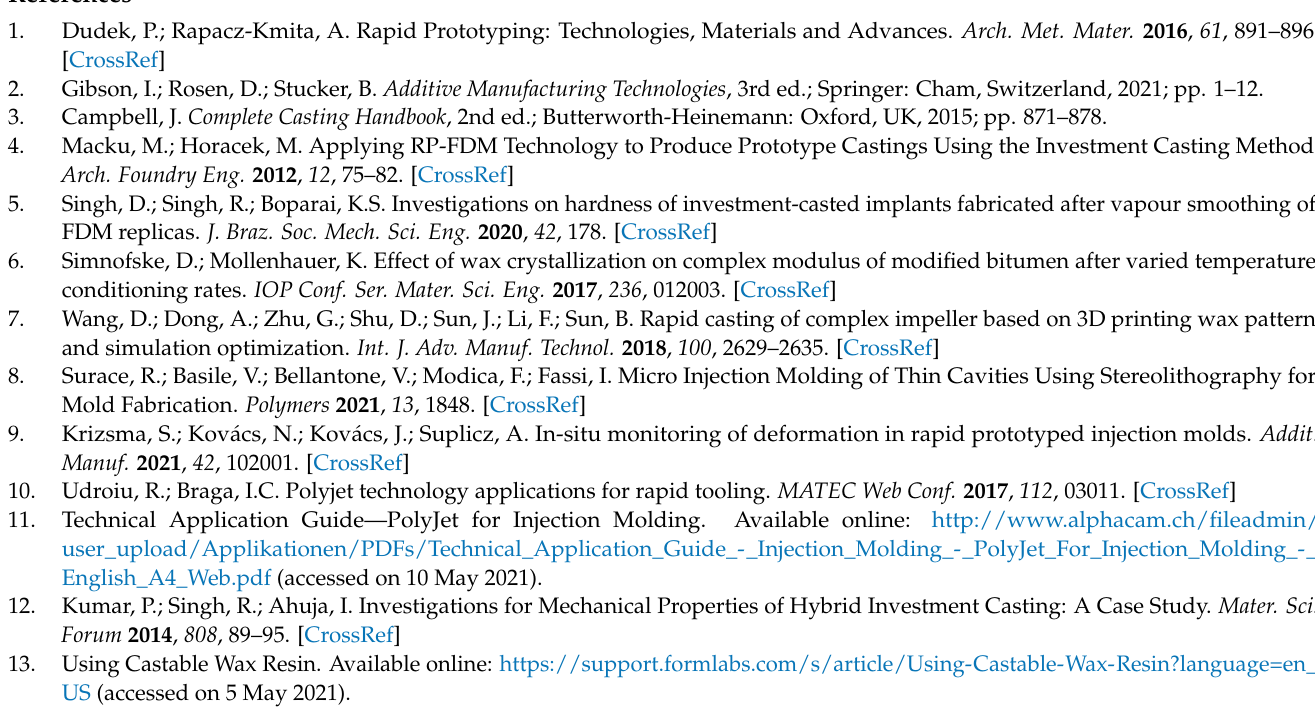
Table S2: Measurement of the fitted circles’ diameters made with BLS, Table S3: Measurement of the fitted circles’ diameters made with FVM, Table S4: Position tolerance values measured with XCT, Table S5: Position tolerance values measured with BLS, Table S6: Position tolerance values measured with FVM, Table S7: Roundness and cylindricity deviation values measured with XCT, Table S8: Roundness and cylindricity deviation values measured with BLS, Table S9: Roundness and cylindricity deviation values measured with